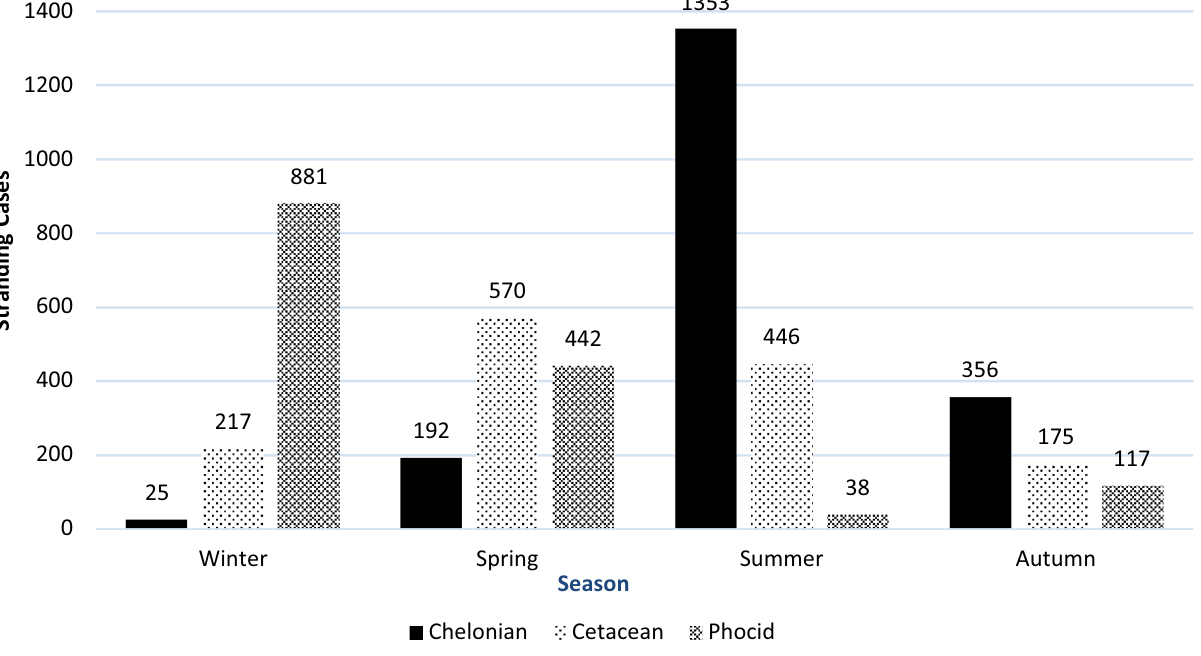
Figure 2. Total number of cases of chelonians, cetaceans and phocids presented the Marine Mammal Stranding Center between 1976 and 2016 according to Temporal patterns of stranding between taxa. More phocids stranded in winter (n = 881) and spring (n = 442) than in summer (n = 38) and autumn (n = 117). The presentation of cetaceans was more evenly distrib- uted throughout all seasons, although more were presented in spring and summer than in autumn or winter (570 in spring, 446 in summer, 175 in autumn, and 217 in winter), Sea turtles had an inverse seasonal distribution with more presented in summer (n = 1,353) and autumn (n = 356) than in winter (n = 25) or spring (n = 192) (Fig. 2). Cetaceans were more likely to strand in spring (OR 1.290, 95% CI 1.14 to 1.46; P < 0.0001), summer (OR 11.436, 95% CI 8.24 to 15.87; P < 0.0001), and autumn (OR 1.496, 95% CI P = 0.001) and less like to strand in winter (OR 0.246, 95% 0.21 to 0.29; P < 0.0001) compared to phocids. Compared to phocids, sea turtles were over 34 times more likely to be presented in summer (OR 34.692, 95% CI 25.23 to 47.70; P < 0.0001) and 3 times more likely to be presented in autumn (OR 3.043, 95% CI 2.47 to 3.75; P < 0.0001). Sea turtles were significantly less likely to be presented in winter (OR 0.028, 95% 0.02 to 0.04; P < 0.0001) and spring (OR 0.043, 95% 0.37 to 0.52; P < 0.0001) compared to phocids. Relative to phocids, cetaceans were substantially more likely to be presented in May through October and less likely to be presented in January through April. There was no considerable difference in likelihood of presentation in November and December. Sea turtles were more likely than phocids to be presented in June through October and less likely to be presented in December through May. There was no considerable difference in likelihood of presentation in November. Likelihoods of death and euthanasia between taxa. Of all animals that were alive at presentation, phocids were over 4 times more likely to be released than to die under care (OR 4.340, 95% CI 3.730 to 5.050; P < 0.0001) but were less likely to be euthanized (OR 0.243, 95% CI 0.178 to 0.331; P = 0.020) or transferred to another facility (OR 0.173, 95% CI 0.154 to 0.296; P < 0.0001). Cetaceans were less likely to be euthanized (OR 0.653, 95% CI 0.456 to 0.936; P = 0.020), to be released (OR 0.507, 95% CI 0.343 to 0.749; P = 0.001), or to be transferred (OR 0.173, 95% CI 0.096 to 0.312; P < 0.0001) than to die while under care. Sea turtles were over 5 times more likely to be released than to die under care (OR 5.667, 95% CI 3.914 to 8.204; P < 0.0001). There were no significant differences between the likelihoods of a sea turtle being transferred to another facility ( P = 0.413) or being euthanized ( P = 0.706) and dying while under care. Of all animals that were alive at presentation, phocids were over 17 times more likely to be released (OR 17.880, 95% CI 13.448 to 23.772; P < 0.0001) and over 4 times more likely to die under care (OR 4.120, 95% CI 3.025 to 5.612; P < 0.0001) than to be euthanized. There was no significant difference between the likelihood of a phocid being transferred to another facility and being euthanized ( P = 0.234). Cetaceans were more likely to die under care (OR 1.531, 95% CI 1.068 to 2.194; P = 0.020) and less likely to be transferred (OR 0.265, 95% CI 0.144 to 0.489; P < 0.0001) than to be euthanized. There was no significant difference between the likelihood of a cetacean being released and being euthanized ( P = 0.240). Sea turtles were more than 6 times more likely to be released (OR 6.233, 95% CI 4.239 to 9.165; P < 0.0001) than to be euthanized. There were no significant